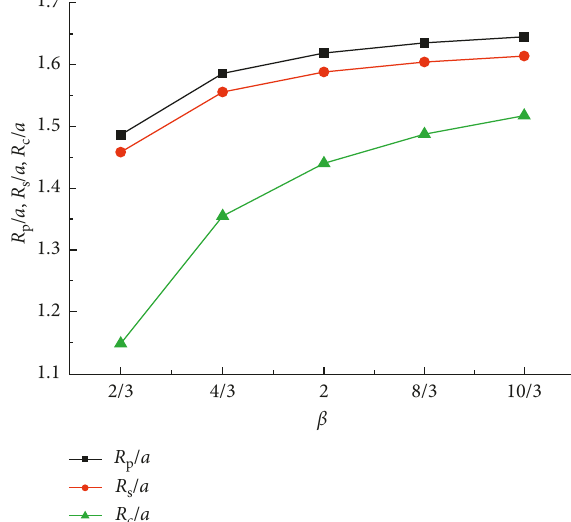
Figure 12: The values of R